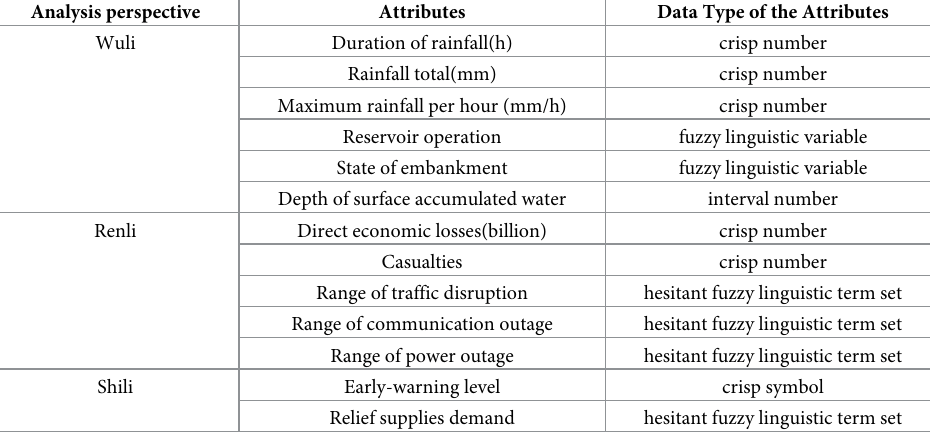
Table 1. Attributes system of urban